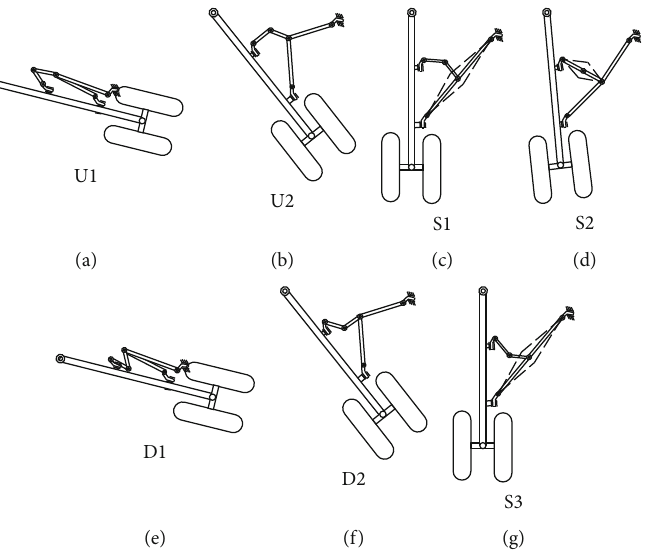
Figure 6: Sketches of the retraction and extension motion of a landing gear: (a) U1; (b) U2; (c) S1; (d) S2; (e) D1; (f) D2; (g) S3.